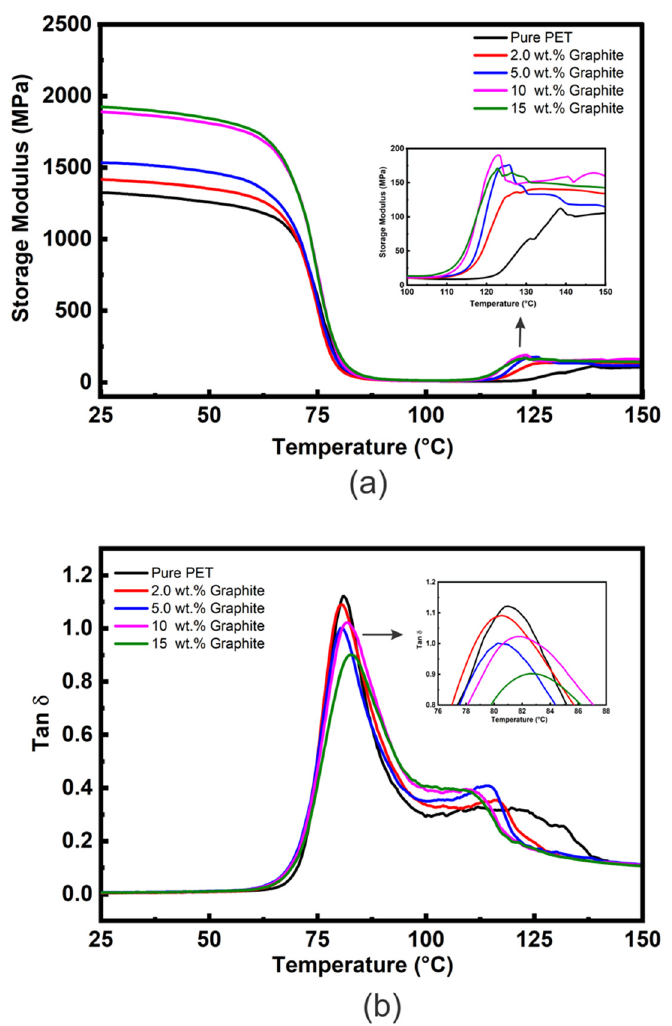
Figure 3. ( a ) DMTA E’ vs. temperature data and ( b ) DMTA tan δ vs. temperature data for the PET/graphite microcomposites. PET/graphite microcomposites. Table 1. Selected DMTA data for E ′ , T g and tan δ of PET/graphite microcomposites. Table 1. Selected DMTA data for E (cid:48) , T g and tan δ of PET/graphite microcomposites. Graphite (wt. %) E ′ at 25 °C (MPa) Graphite (wt.